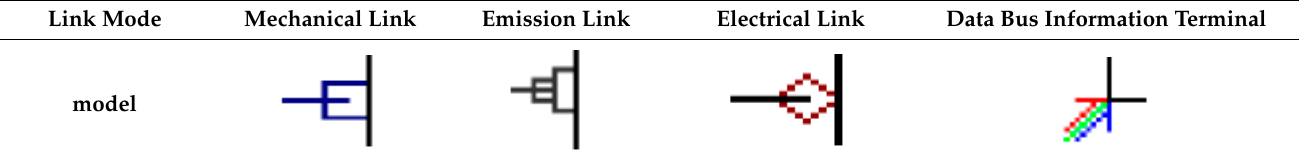
Table 2. The connection between the models in CRUISE.